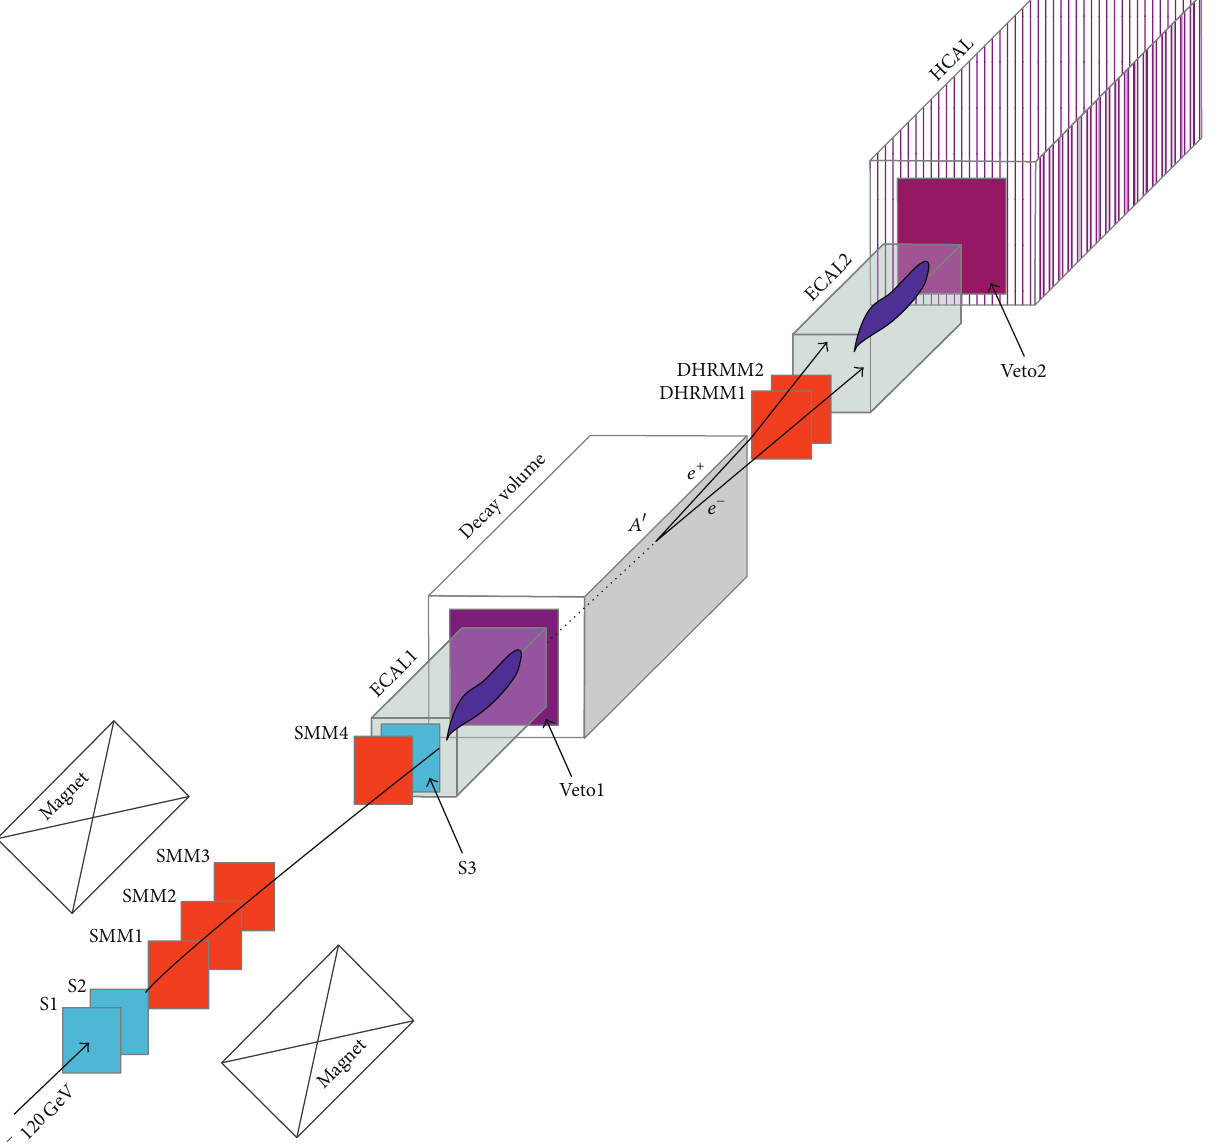
Figure 2: Experimental setup for the P348